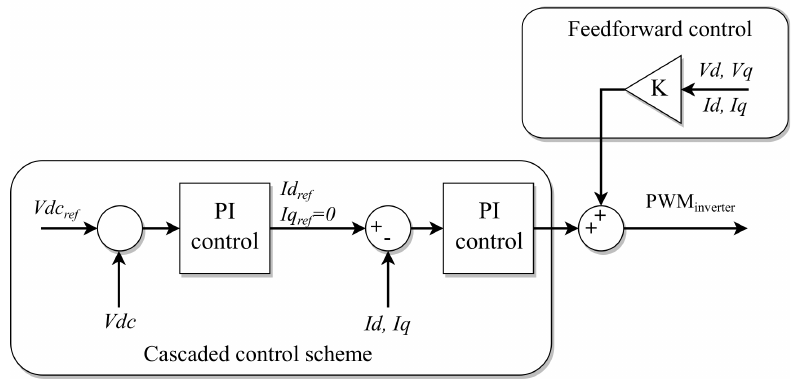
Figure 6. Feedforward and cascaded control of inverter.